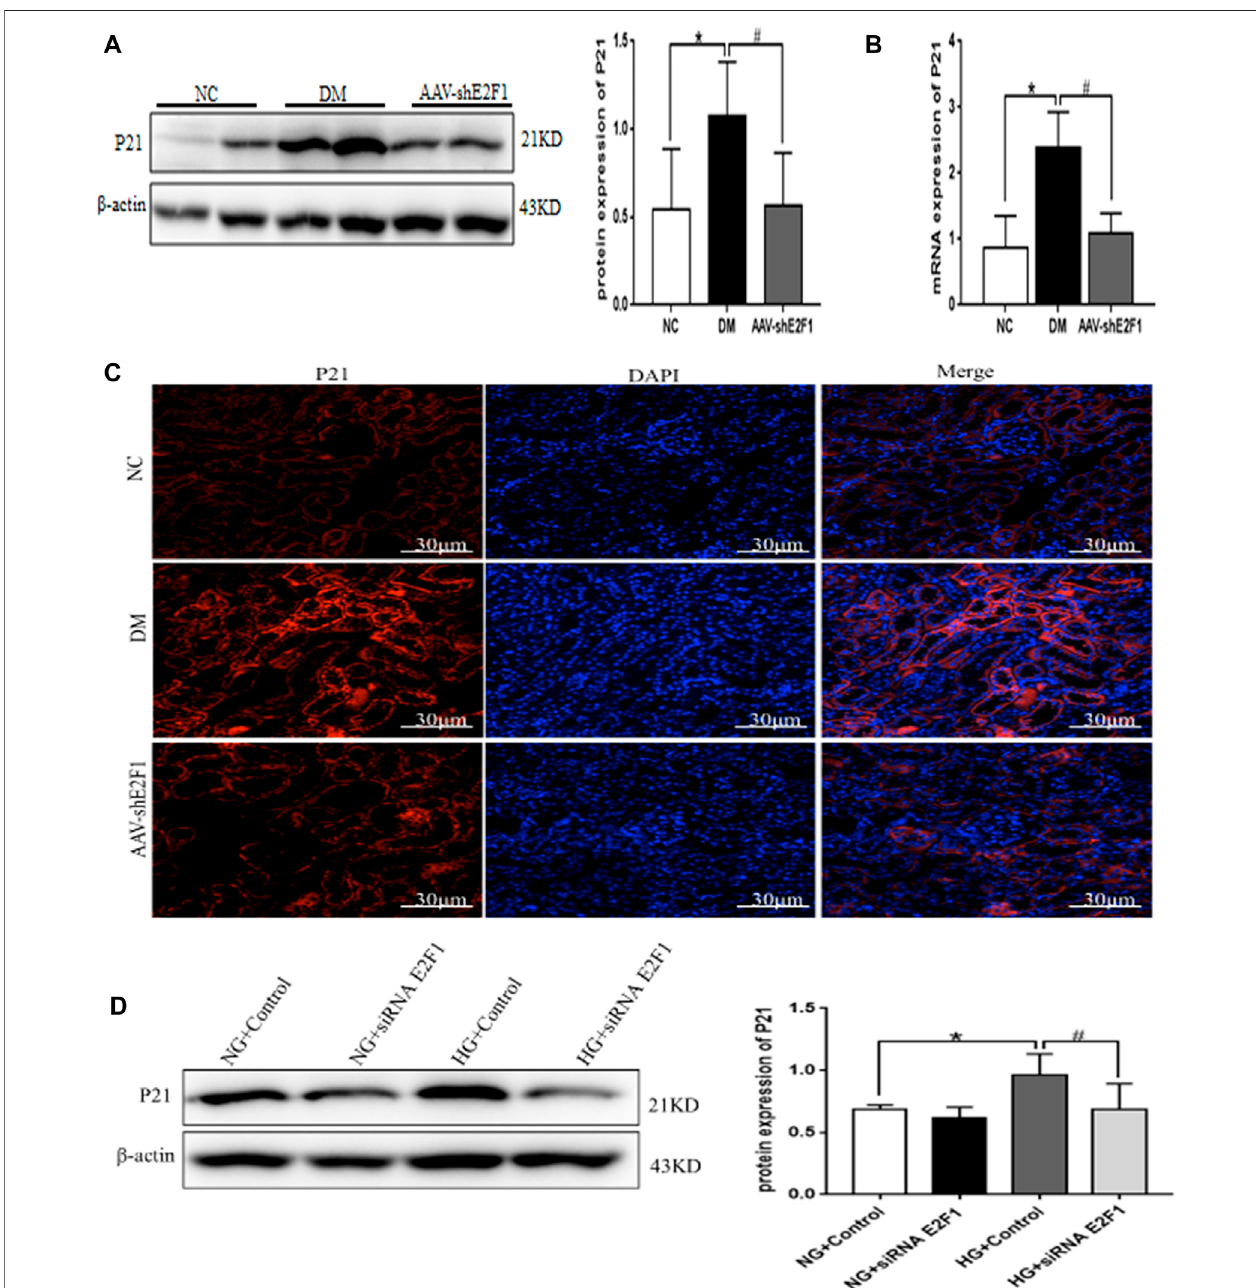
FIGURE 7 | High expression of E2F1 promotes cellular senescence of renal tubular epithelial cells in the high-glucose state. (A) Western blot analysis of P21 in the renalcortexofmiceineachgroup(n=6,* p < 0.05vs.NC, # p < 0.05vs.DM). (B) Real-timePCRanalysisofP21intherenalcortexofmiceineachgroup(n=6,* p < 0.05 vs. NC, # p < 0.05vs. DM). (C) Tissueimmuno fl uorescence ofP21intherenalcortexofmice ineach group. (D) Western blotanalysisofP21inmRTECs (n=3,* p < 0.05 vs. NG + Control, # p < 0.05 vs. HG +